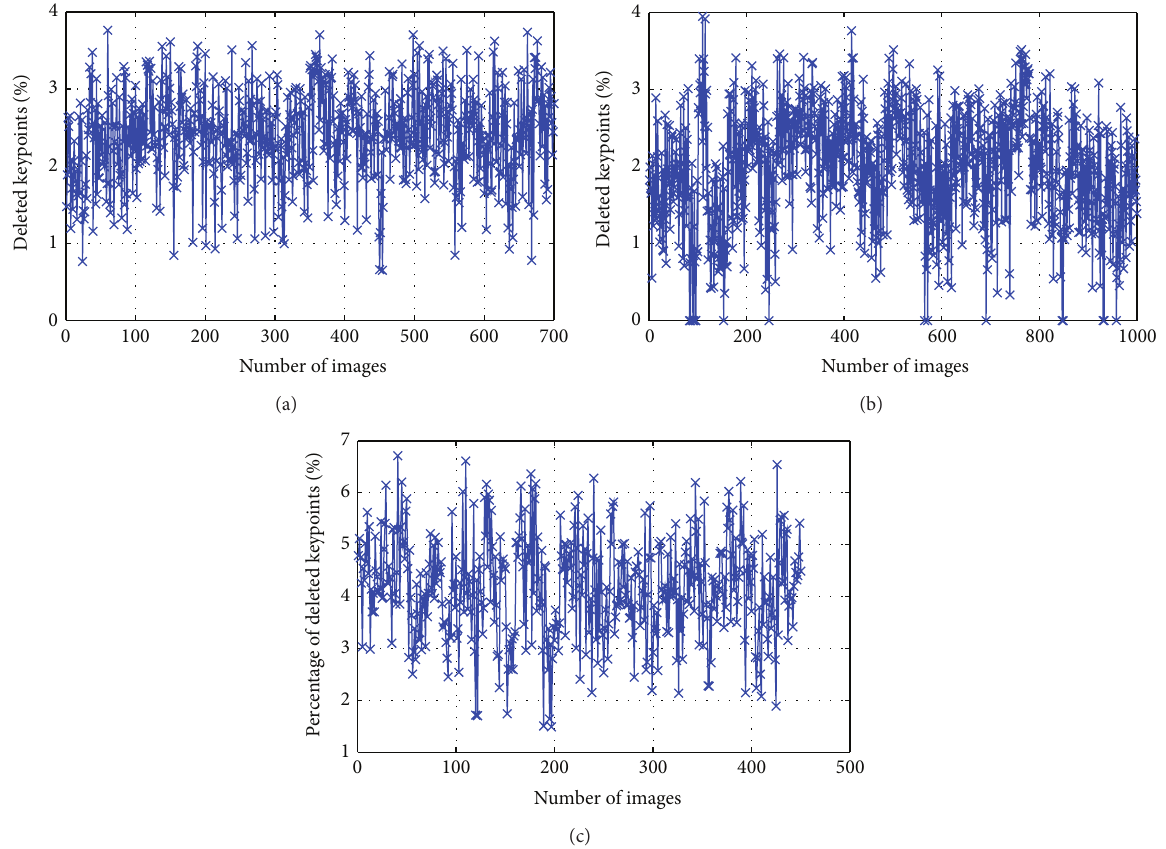
Figure 15: Percentage of deleted keypoints based on orientation. (a) CASIA-V3 Interval, (b) CASIA-V3 Lamp, and (c) MMU-V1.